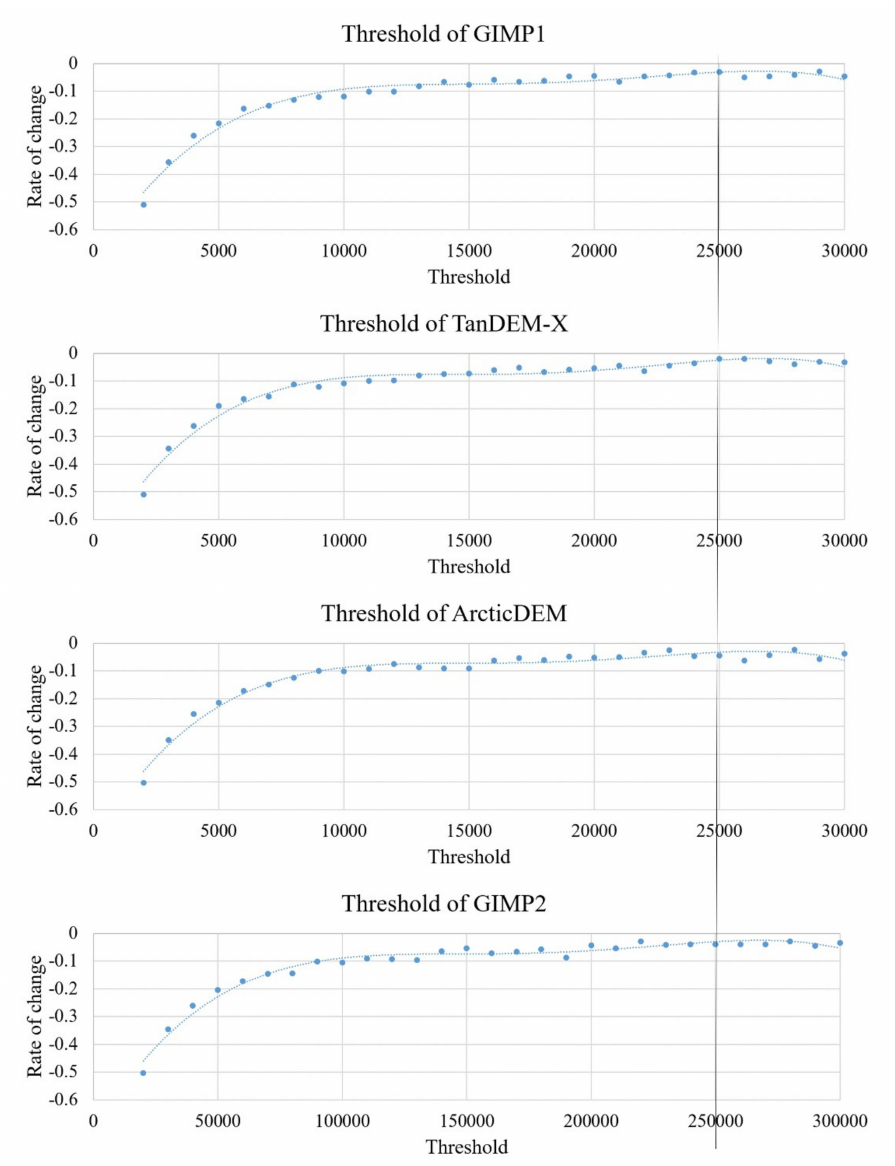
Figure 4. The fitting relationships between the extraction threshold and the rate of change in the number of extracted river